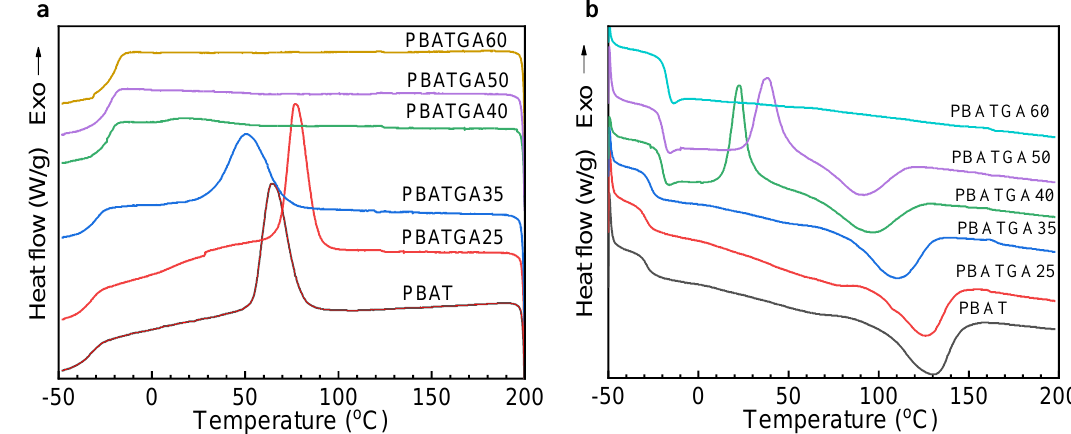
Figure 3. DSC curves of PBATGAs for cooling ( a ) and reheating ( b ) processes with condition 10 °C/min.